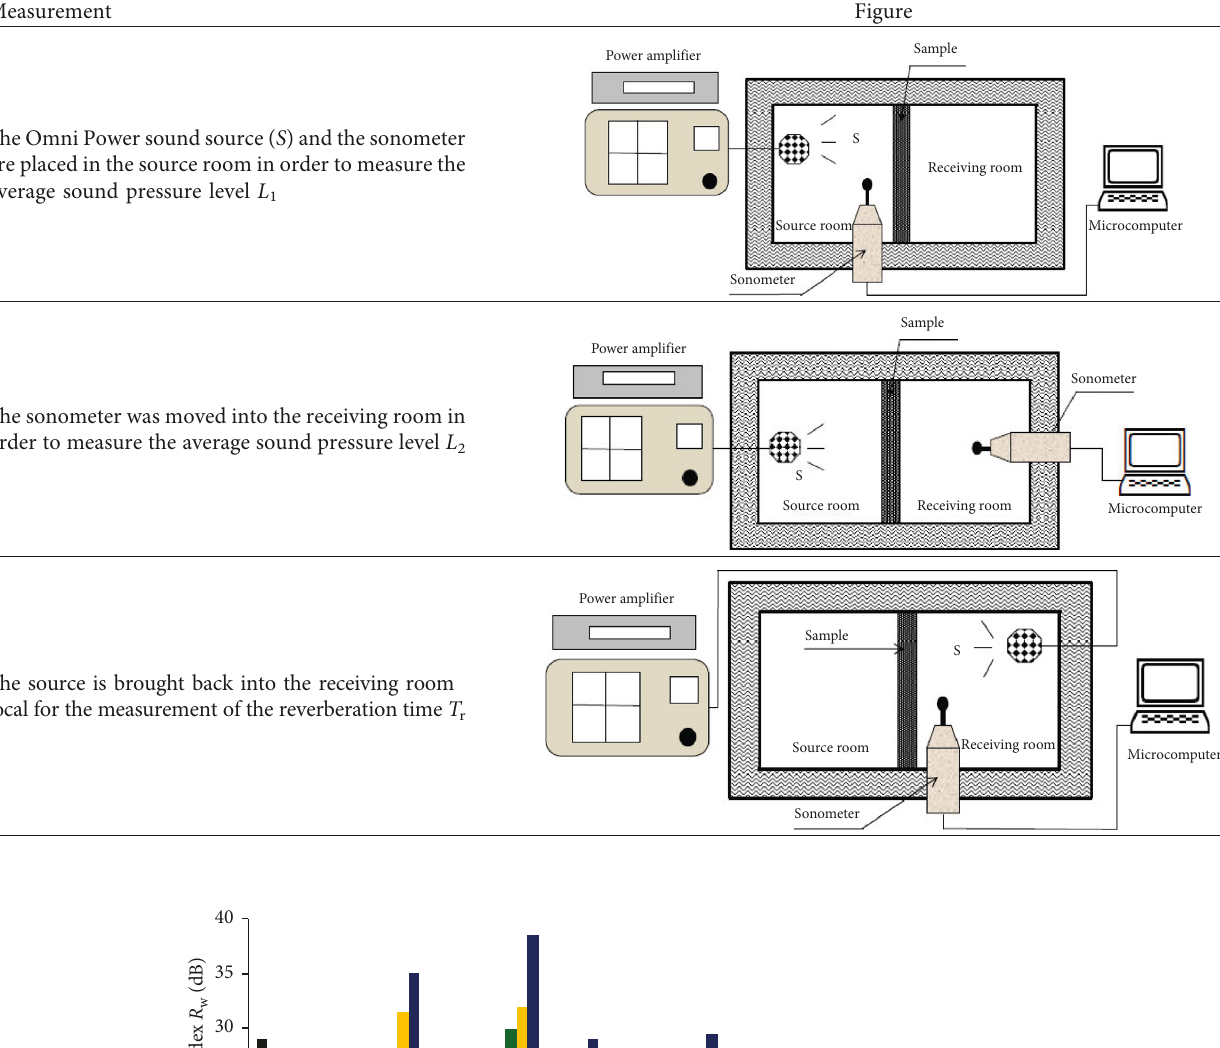
Table 8: Measuring principle of the sound reduction index R